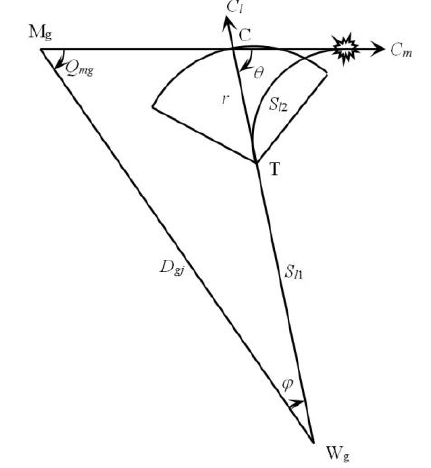
Fig. 1. Acoustic homing torpedo attack